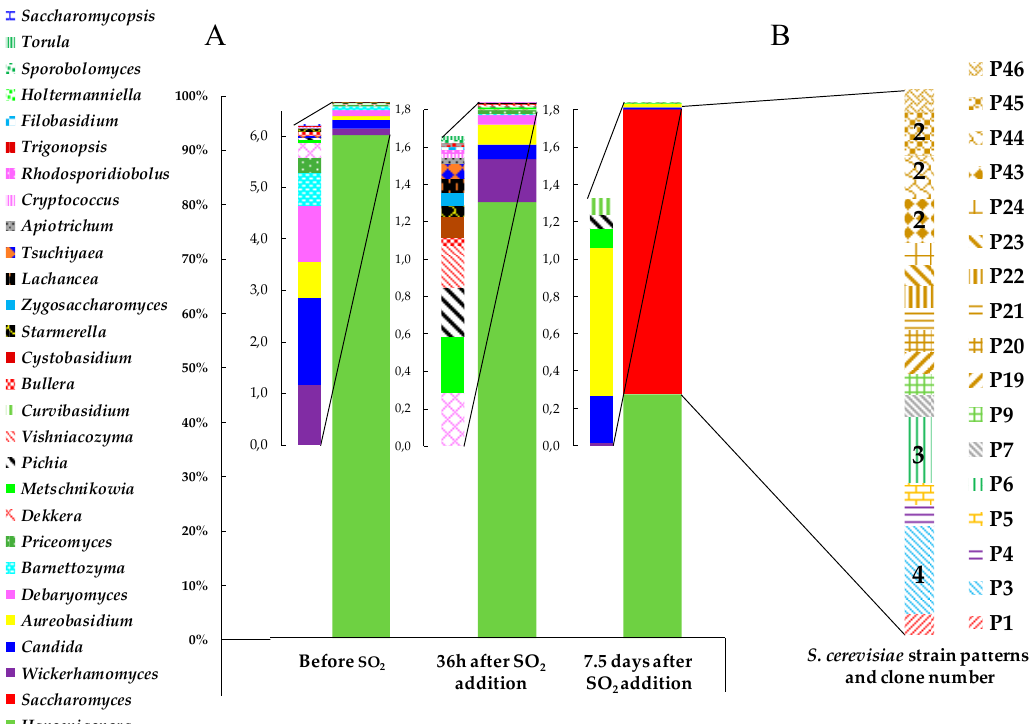
Figure 1. ( A ) Relative abundance of fungal genera identified in ‘Pied de Cuve’ for vintage 2016. ( B ) Number of isolates for S. cerevisiae strains in ‘Pied de Cuve’ at 7.5 days after SO 2 addition. Only the number of isolates per strain ≥ 2 is noted.